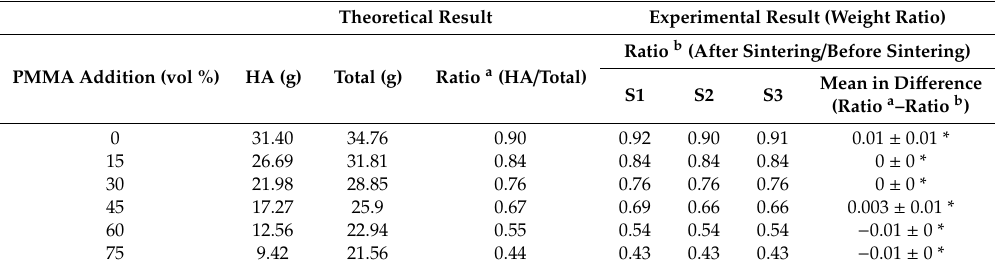
Table 1. Comparison of the weight ratio between theoretical and experimental results before and after sintering for verification of the removal of PMMA and residual organics.